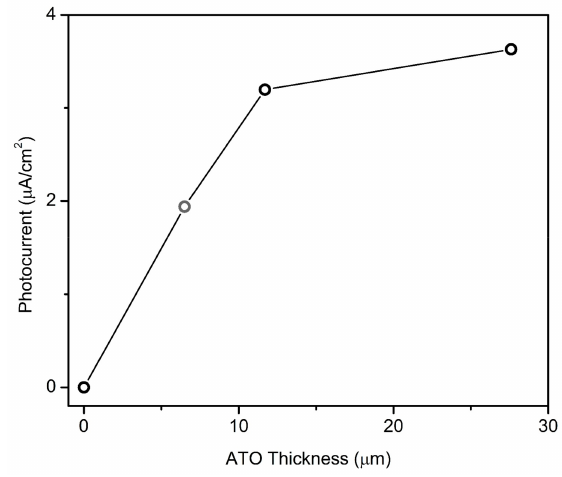
Figure 5. Photocurrent measurements of Rb. sphaeroides RC attached to cyt c modified ATO coatings with various thicknesses.